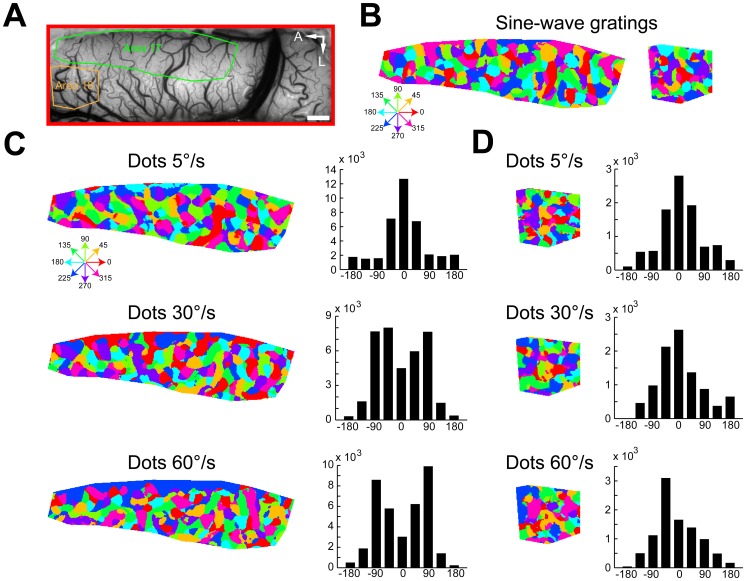
Direction preference maps calculated by vector maximum were changed with moving speed of random-dot stimuli.(A) Image of the cortical vasculature. The green and orange polygons indicate regions of areas 17 and 18 selected for analysis, respectively. Note that the selected regions are the same regions analyzed in Figure 7. A, Anterior; L, lateral. Scale bar: 1 mm. (B) Direction preference maps calculated by vector maximum acquired using sine-wave grating stimuli in areas 17 and 18. Hues in the color maps indicate direction preferences. (C–D) Direction preference maps calculated by vector maximum acquired using random-dot stimuli with different speeds in areas 17 (C) and 18 (D). Angular differences between direction preference maps of sine-wave grating and of random-dot stimuli with different speeds are shown in the histograms. Computed from the angular-difference histograms of 5°/s, 30°/s, and 60°/s, the percentages of pixels with angular difference between −45° and 45° amount to 71%, 49%, and 40% in area 17 (C) and 69%, 64%, and 65% in area 18 (D), respectively.